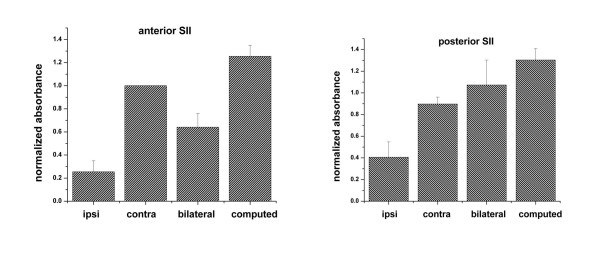
Averaged normalized absorbance values (n = 6) obtained at 3 seconds after stimulus onset with respect to the contralateral stimulus in the anterior and posterior SII region. Computed response is the summation of the ipsilateral and contralateral responses. Left Panel: The contralateral stimulus in the anterior SII region evoked the greatest cortical response, while the ipsilateral stimulus was significantly lower. The bilateral response, however, evoked a cortical response that fell between the ipsilateral and the contralateral evoked responses. Note that the bilateral response is lower than the computed response. Right Panel: The ipsilateral response in the posterior SII region is greater than the ipsilateral response in the anterior SII region. The difference between the ipsilateral and contralateral responses is not as great in the posterior SII region as it was observed in the anterior SII region. Note that the bilateral response is larger than both the ipsilateral and contralateral responses, but still remains less than the computed value.